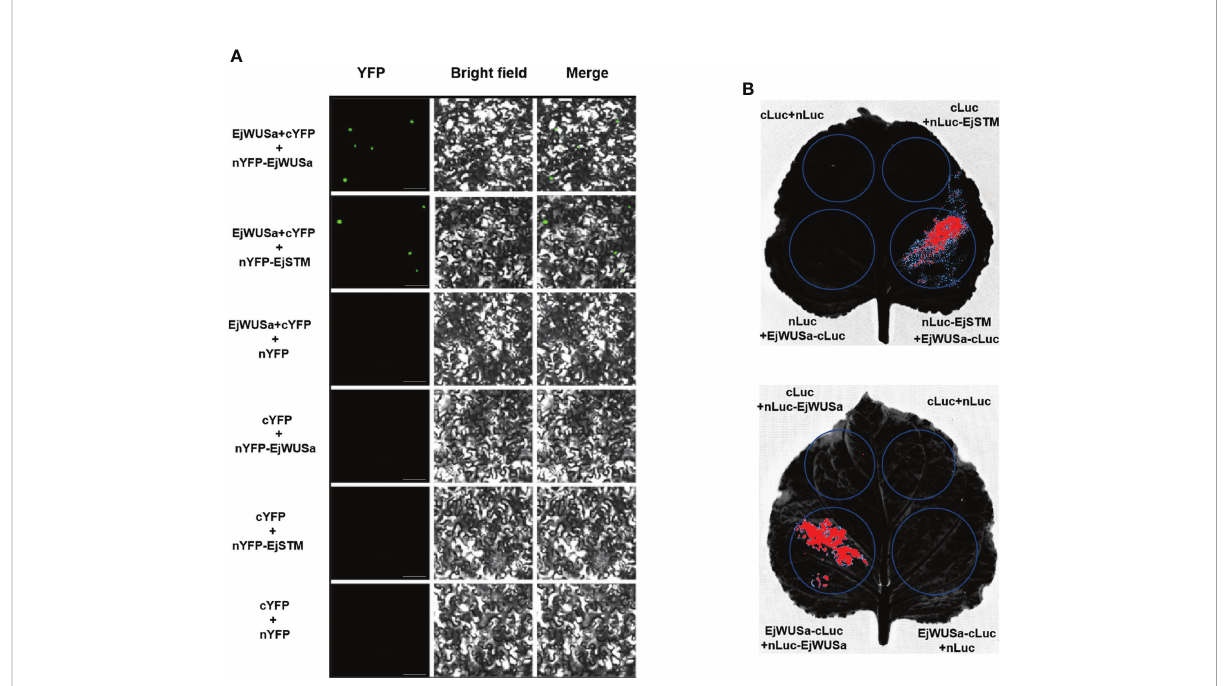
FIGURE 7 Protein interactions between EjWUSa with EjWUSa and EjSTM. (A) Protein interactions between EjWUSa with EjWUSa and EjSTM were demonstrated in the BIFC assay. The scale bar is 20 m m. (B) Protein interactions between EjWUSa with EjWUSa and EjSTM were demonstrated in the LCI